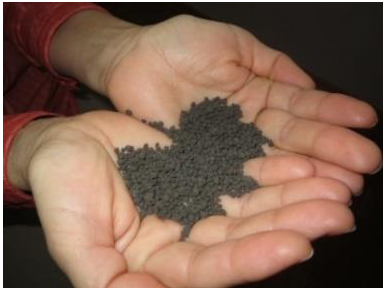
Figure 4. Hygienized, anaerobically